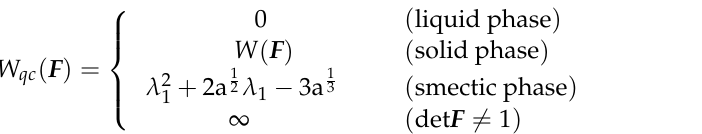
Figure 5. Idea of rank-one lamination of the deformation gradient. ( a ) Example of laminate of compatible gradients A and B with volume fractions λ , 1 − λ , respectively (Adapted with permission with permission from [47]. 2004, Ball, J.M). ( b ) Upper: demonstration of material continuity between dissimilar deformations F 1 , F 2 by rigid body rotation. Bottom: lamination leading to stripe domain shown in nematic monodomains (Adapted with permission from [49]. 2009, Biggins, J.S. et al.).